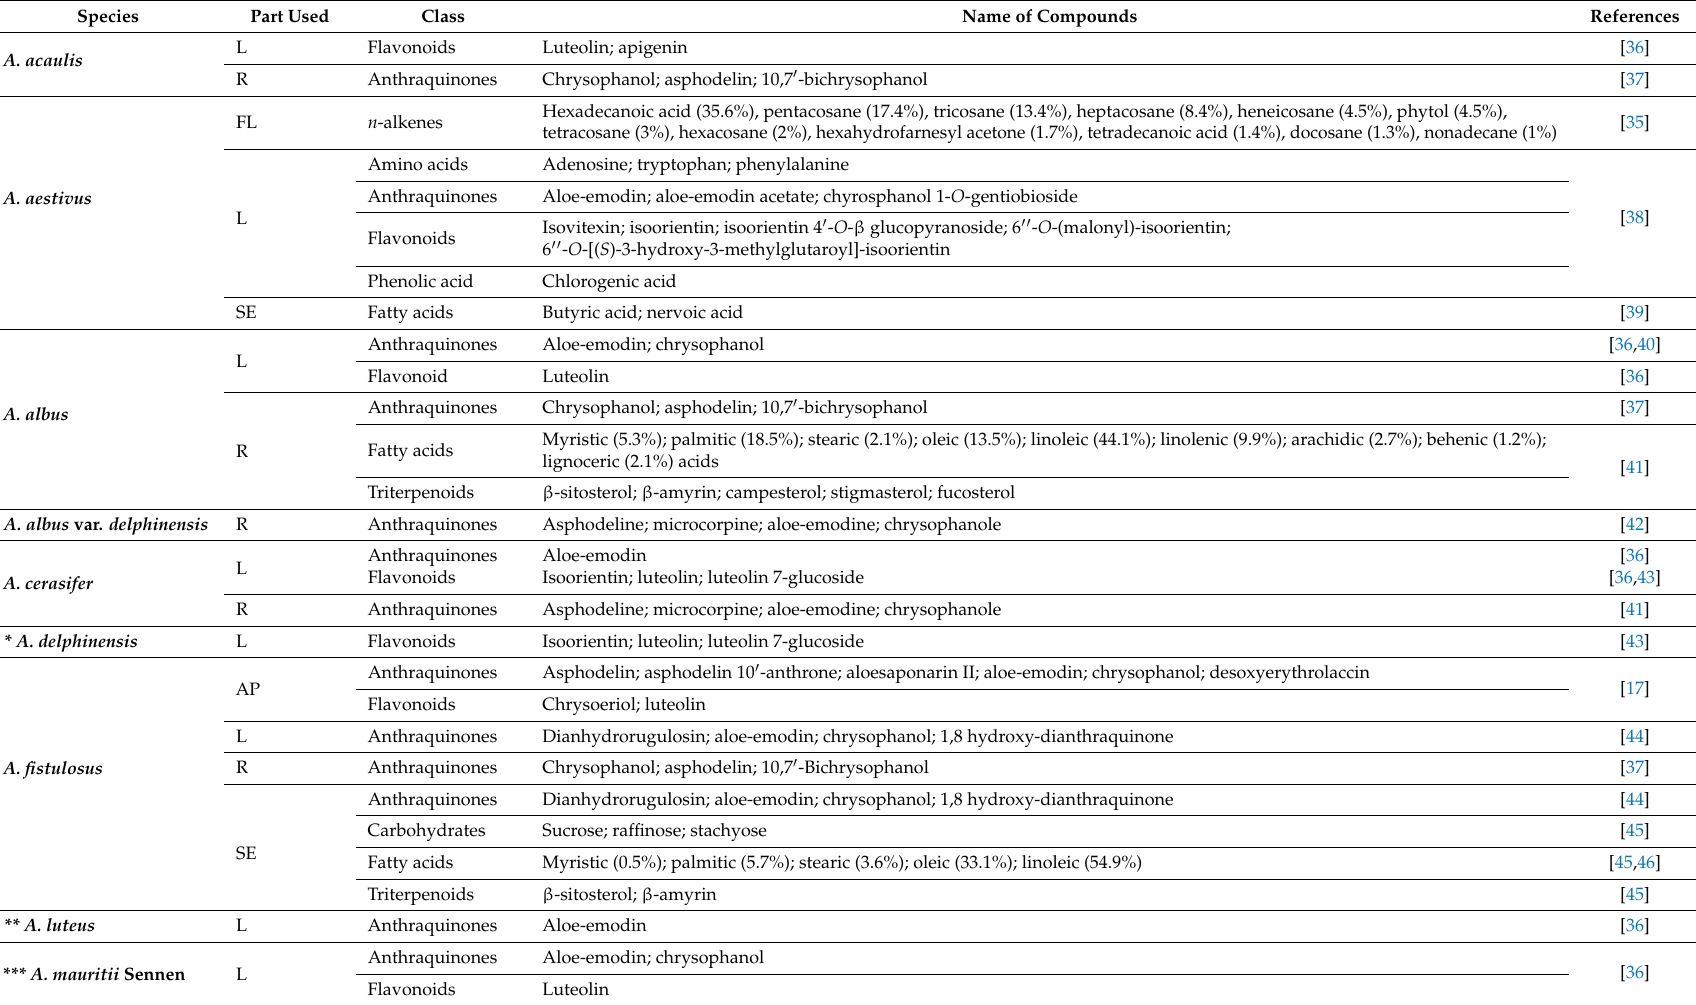
Table 2. Identified compounds reported from Asphodelus